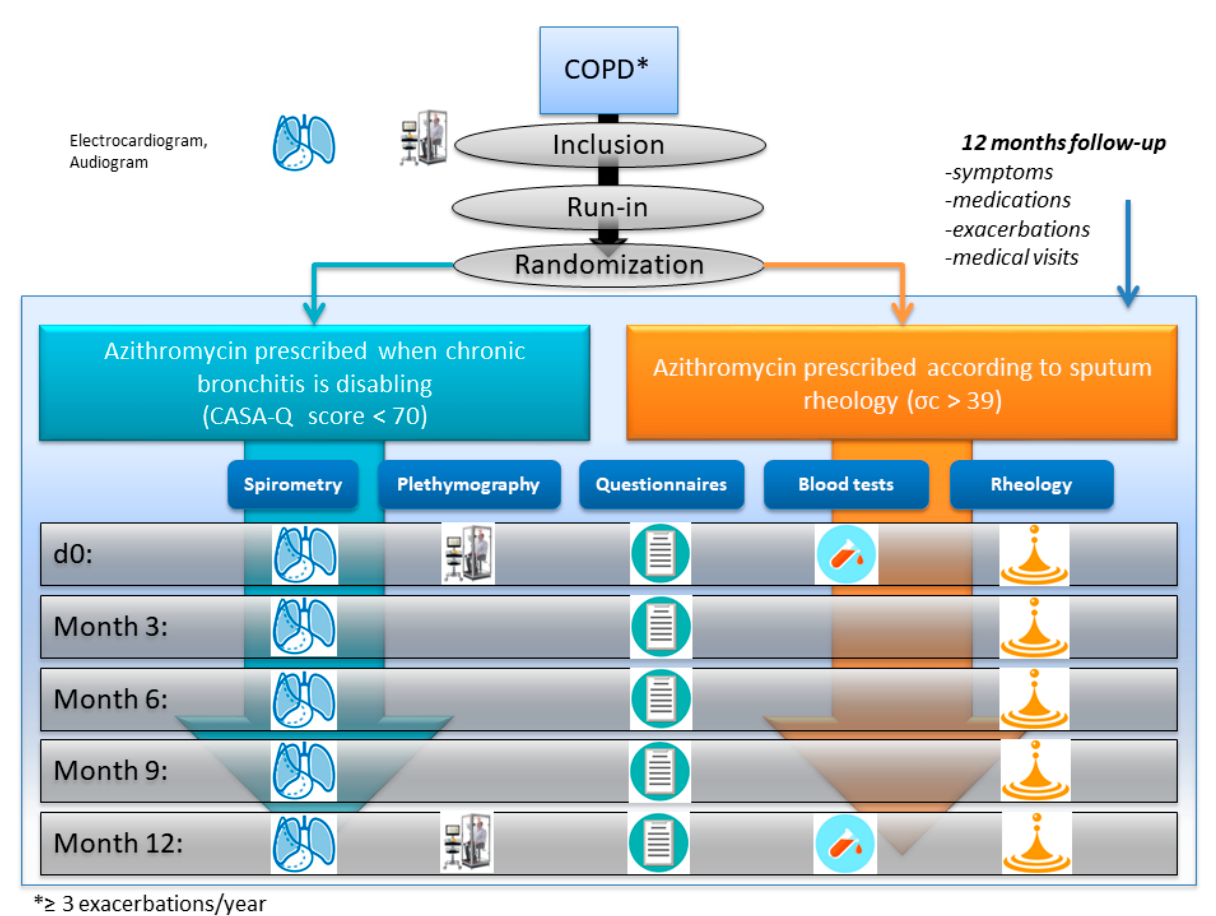
Figure 1. Study Design. Table 1. Eligibility